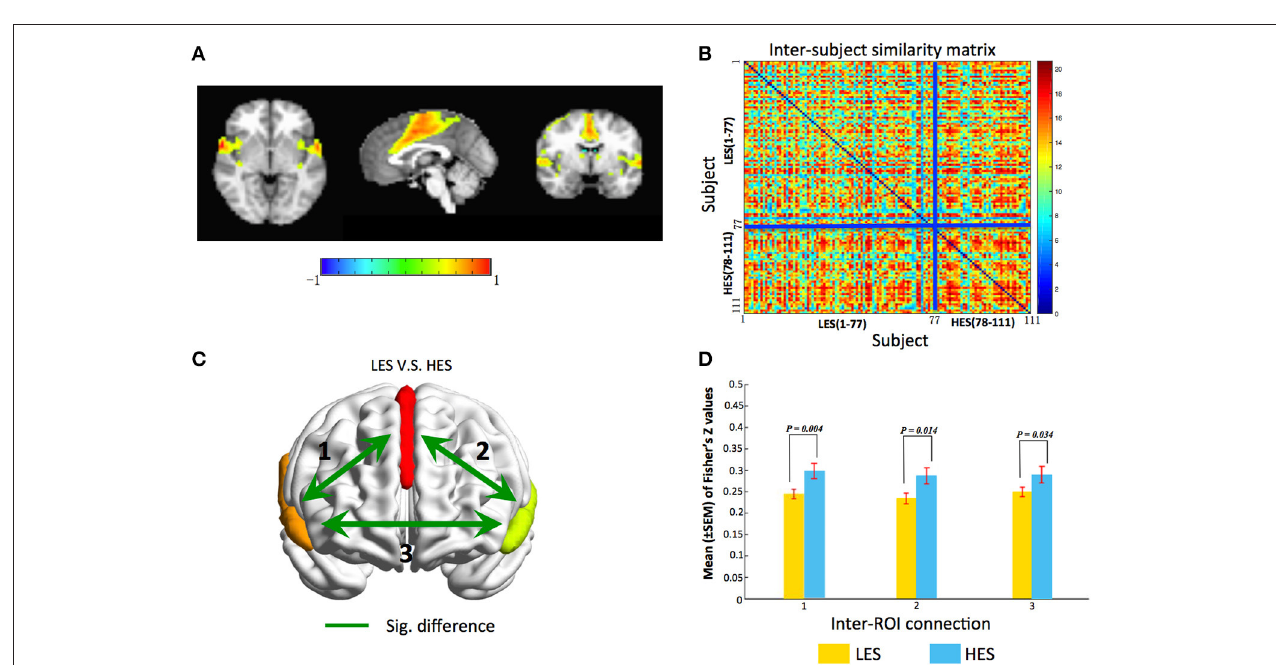
FIGURE 2 | gRAICAR reveal the salience network is associated with Extraversion classification. (A) The salience network dominated by the anterior cingulate and bilateral anterior insula. (B) Combined with the Extraversion scores, the similarity matrix change into a regular distribution. Compared to the LES subjects, the HES subjects have a higher inter-subjects average similarity. For visualization purpose, the subjects are grouped into LES and HES groups, and the blue solid lines mark the boundary between the two groups. (C) Map of the salience network showing inter-regional connections exhibiting significant (green line) differences in connectivity strength (Fisher’s Z) between LES and HES groups. (D) Bar graphs showing separately statistical details comparing functional connectivity strength between LES and HES groups. Labels along the horizontal axis correspond to the connections marked on (C) . All three inter-ROI connections show significant difference between LES and HES groups. The surface maps are rendered in BrainNet Viewer (Xia et al., 2013).